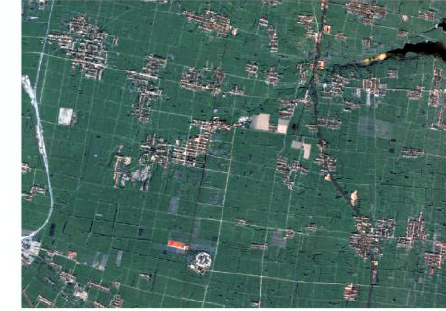
Figure 3. GF-1 true-colour fusion